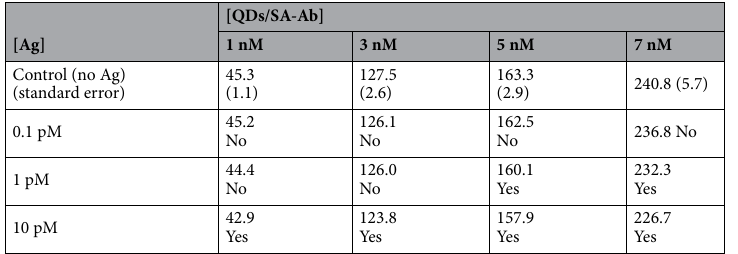
Table 1. Comparison of fluorescence intensity of QDs/SA-Ab-Ag with that of control sample (no Ag) and detectability of fluorescence quenching at several different concentrations of QDs/SA-Ab and Ag. Yes: fluorescence quenching was detectable. No: fluorescence quenching was not detectable. The PL emission data of all the samples were measured at 653 nm.